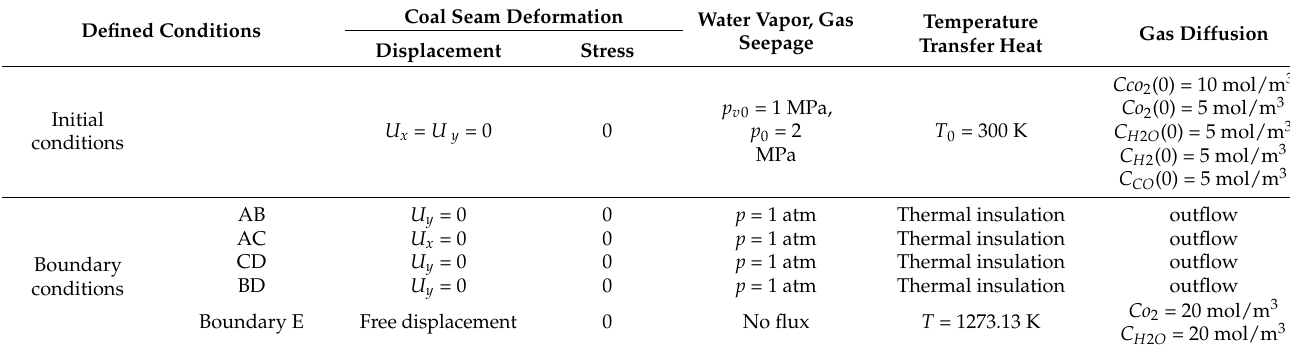
Table 3. Boundary and initial conditions for numerical